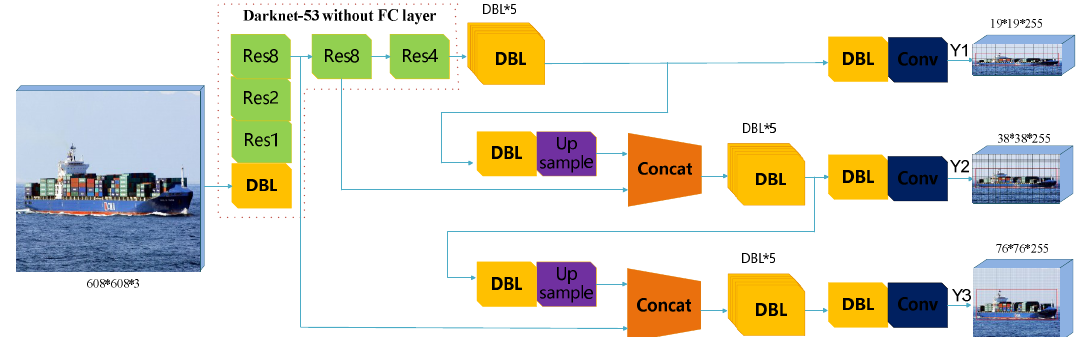
Figure 2. Framework of the detector. Among them, Darknetconv2d_BN_Leaky (DBL) is the basic unit, which consists of a convolutional layer (conv), batch normalization, and a leaky rectified linear unit (ReLU).